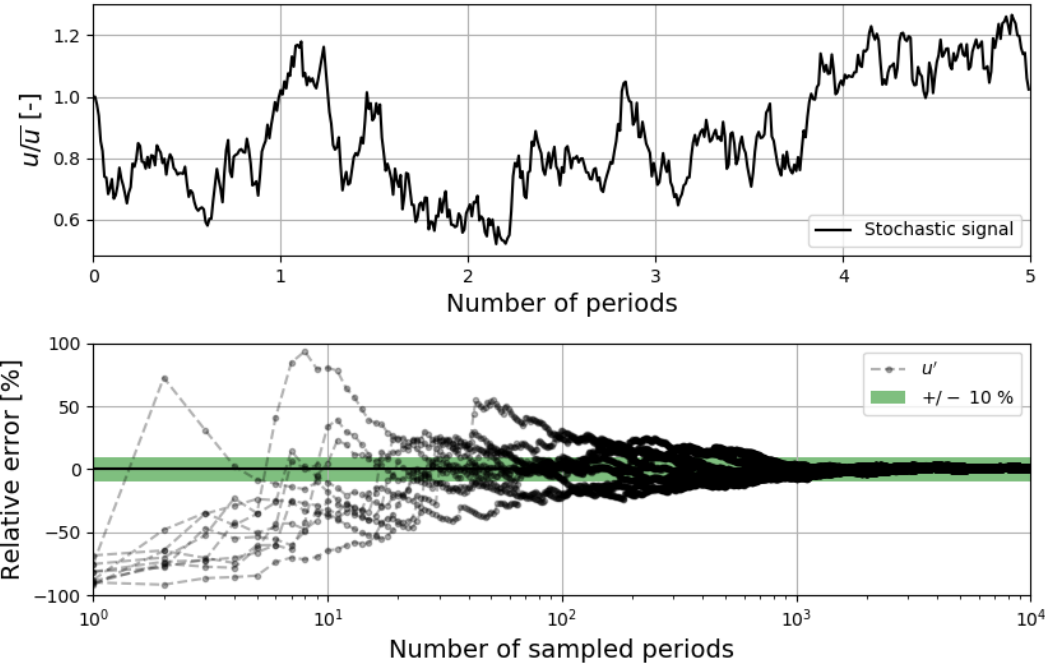
Figure 5. Uncertainty related to the limited sample time. ( top ): Velocity signal for the first five periods, ( bottom ): error due to the limited sampled periods (relative to the entire signal). Each period contains 100 data